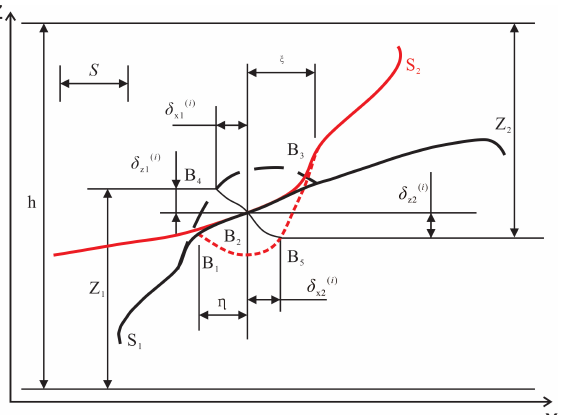
Figure 1. Contacting state of a pair of micro asperity after a relative sliding distances: s, relative sliding distance; h, distance between two reference planes; S 1 , S 2 , contact surface; Z 1 , distance in the z-direction of the contact surface s1 before deformation; Z 2 , distance in the z-direction of the contact surface S 2 before deformation; η , ξ , distance in x-direction of micro-convex body after deformation; ∂ z, displacement in z-direction; ∂ , displacement in x-direction.